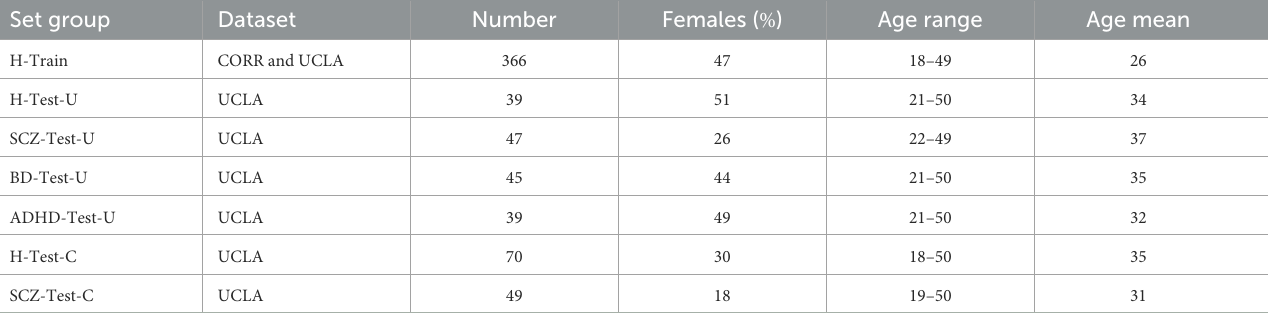
TABLE 2 Datasets for the normative